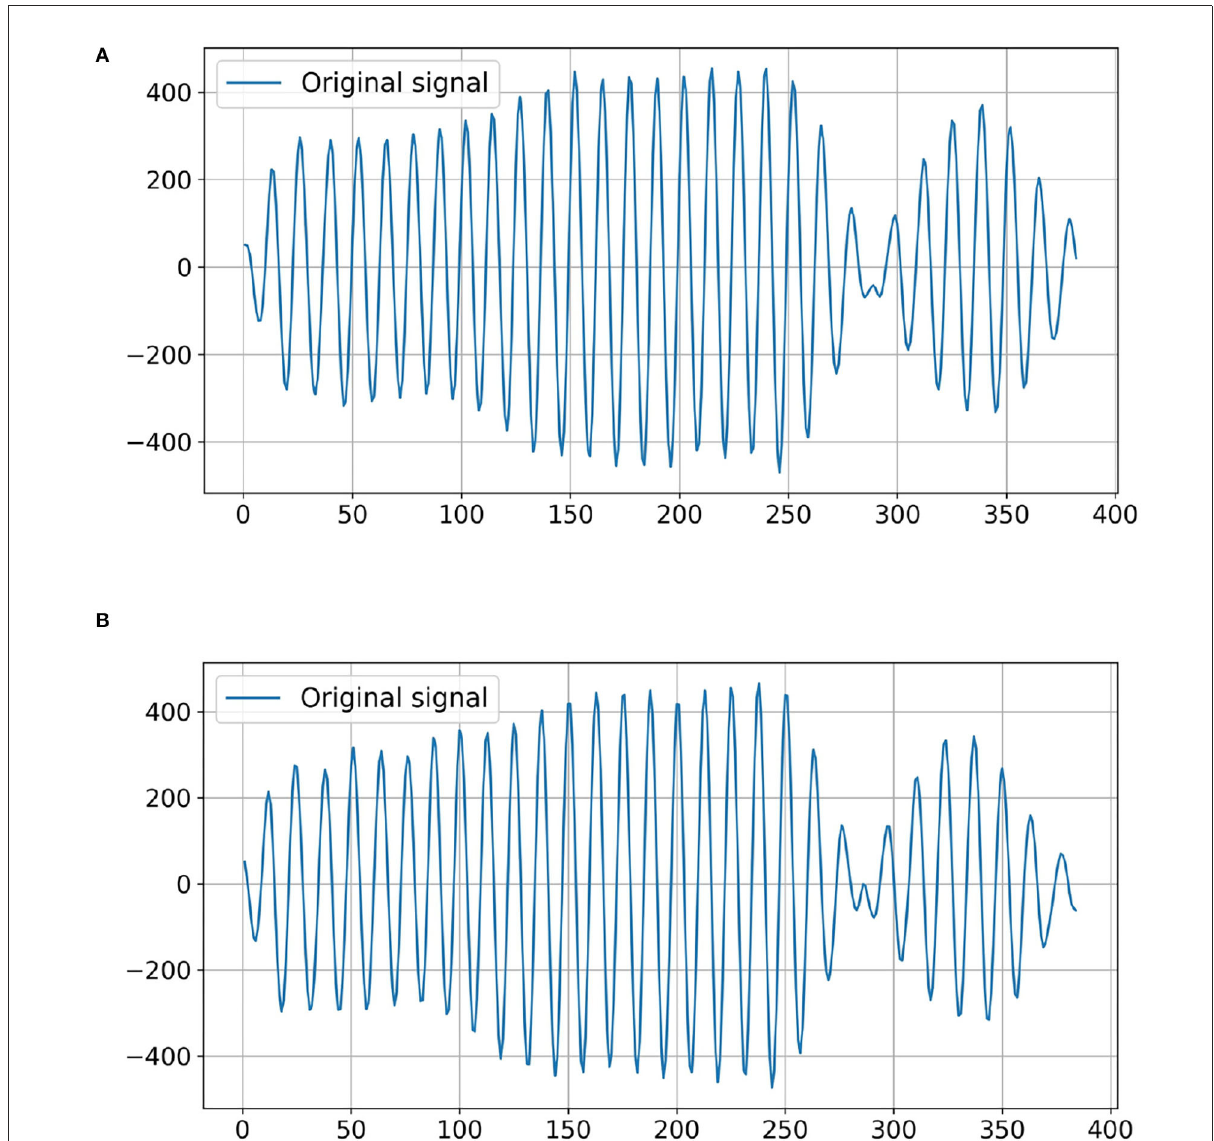
FIGURE3 Examples of the original ultrasonic signals of cottonseed. (A) Intact cottonseed. (B) Cottonseed with slight